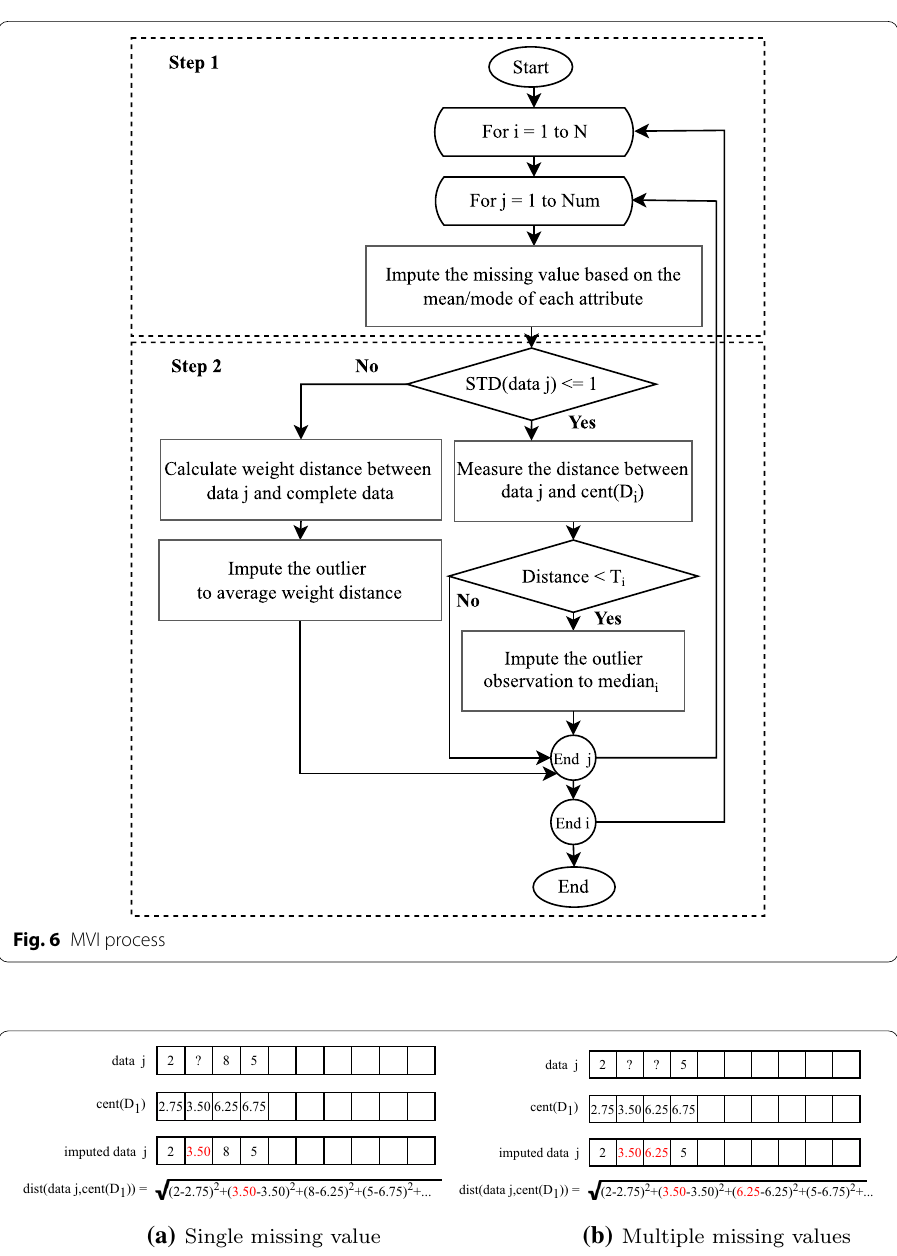
Fig. 7 Example of imputing a numerical dataset for ( a ) a single missing value, and ( b ) multiple missing values